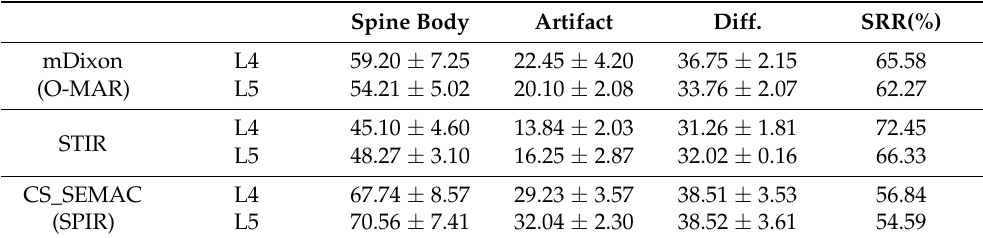
Table 8. The difference in signal intensity between the spinal body and artifact parts with a transplant patient.